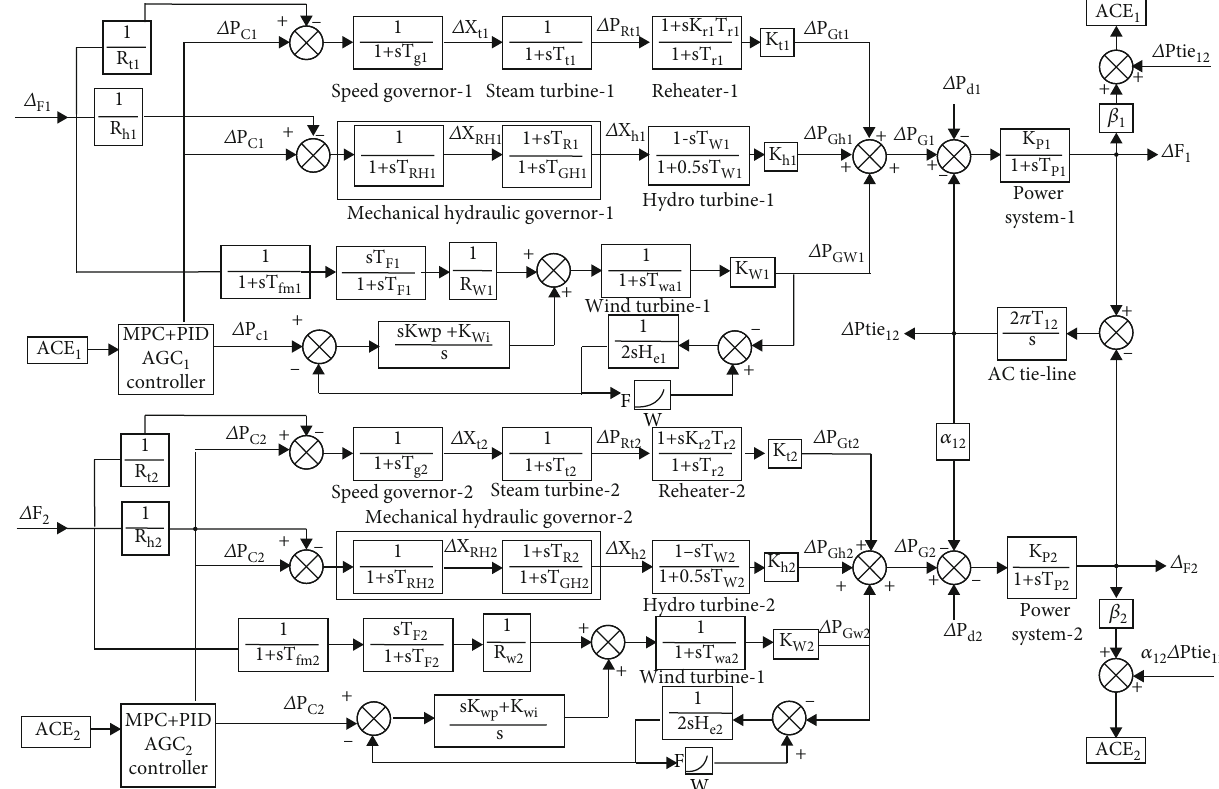
Figure 1: Transfer function model of multisource power system for MPC+PID AGC